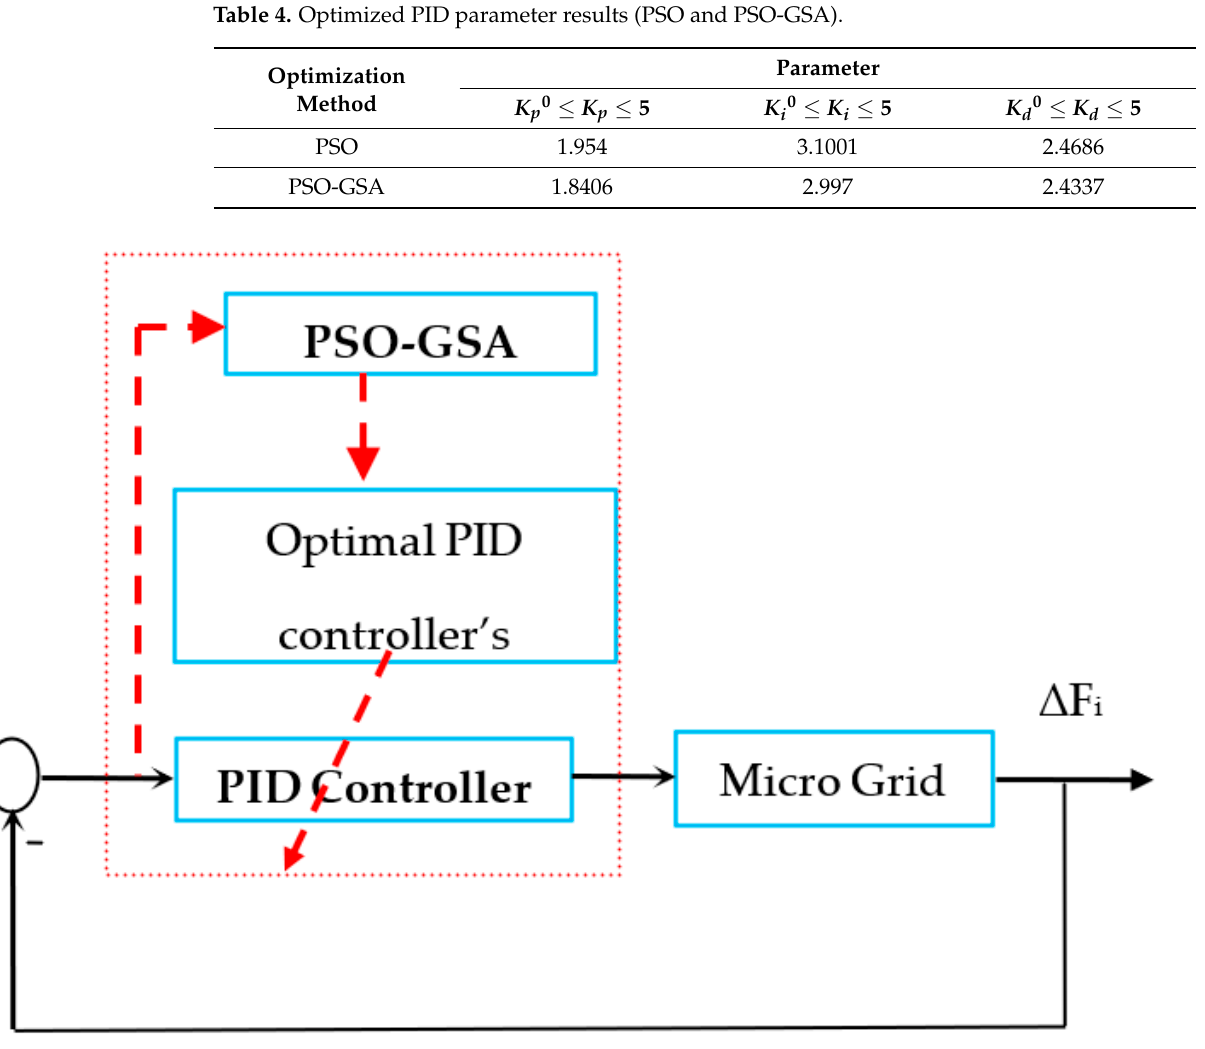
Table 2. Nominal microgrid power [55,56].